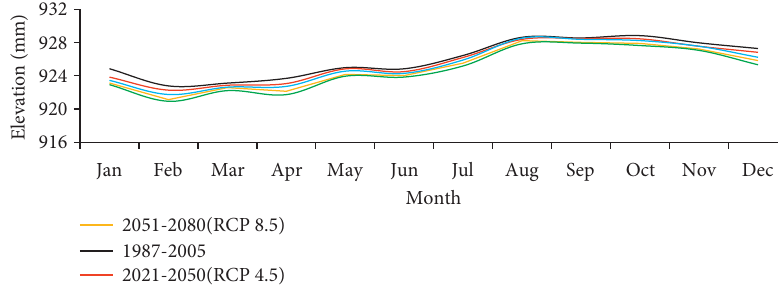
Figure 21: Reservoir operation guide curve.